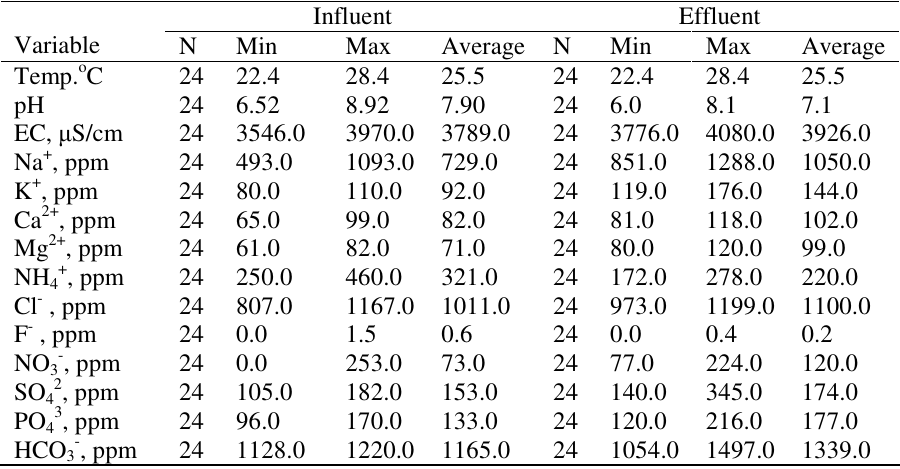
Table 1. Physicochemical parameters for wastewater effluent in summer